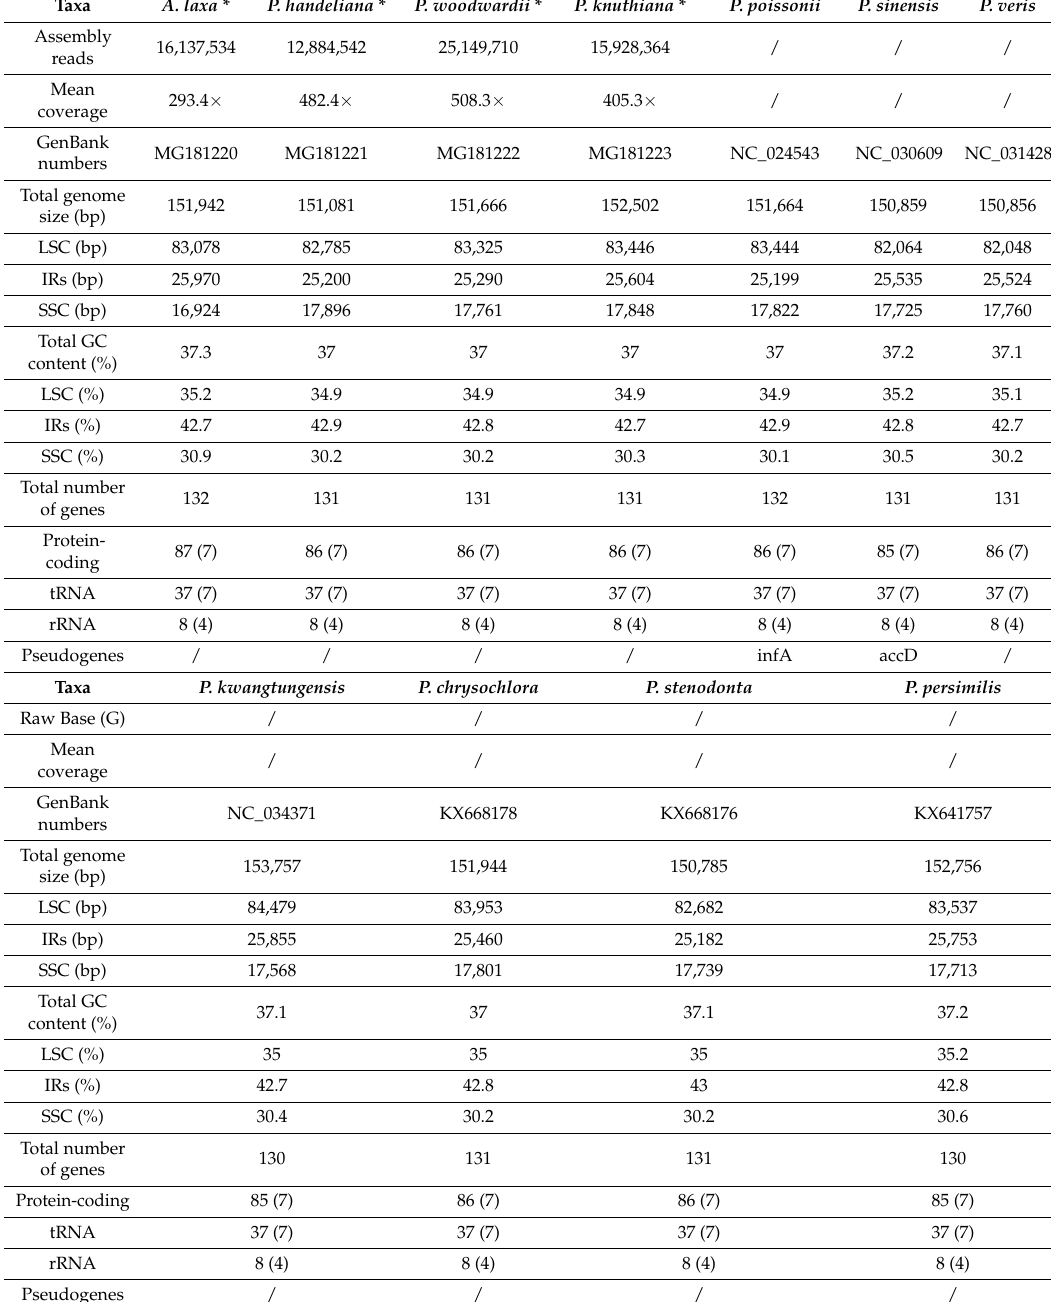
Table 1. Plastid genomic characteristics of the 10 Primula species and A.